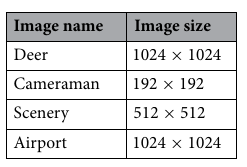
Table 1. Selected sample image details.